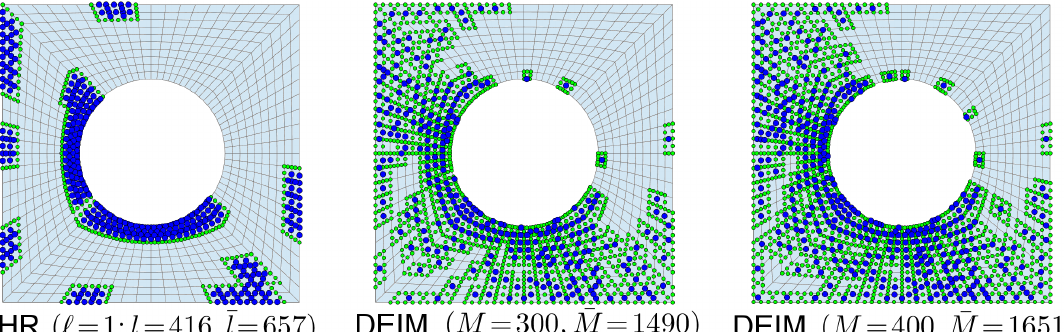
Figure 7. Position of the magic points (blue points) and the additional points required for the evaluation of the residual (green points); Hyper-reduction (left) vs. DEIM (middle, right) for m =